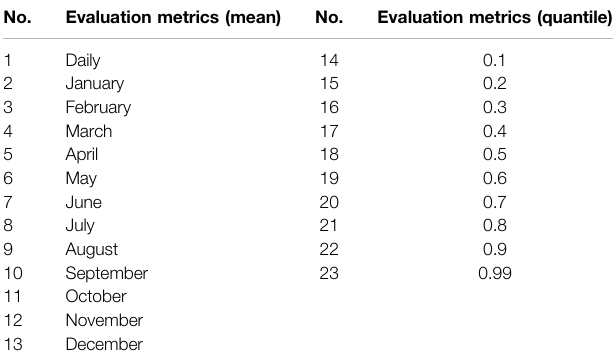
TABLE 3 | List of evaluation metrics for precipitation and temperature.